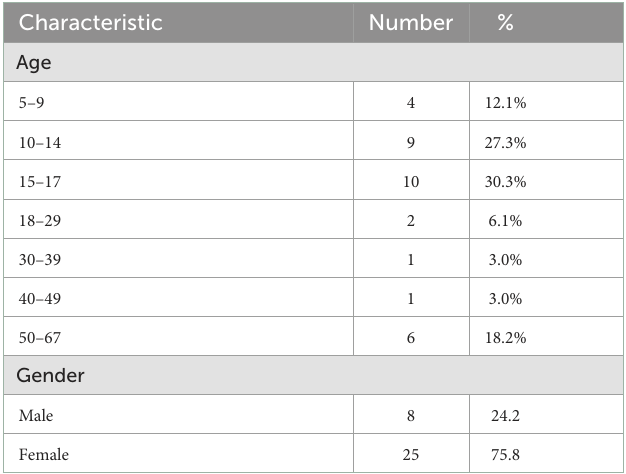
TABLE 4 Children with and without eyeglasses at the beginning of the intervention (i.e., during the appointment with the optometrist) and ∼